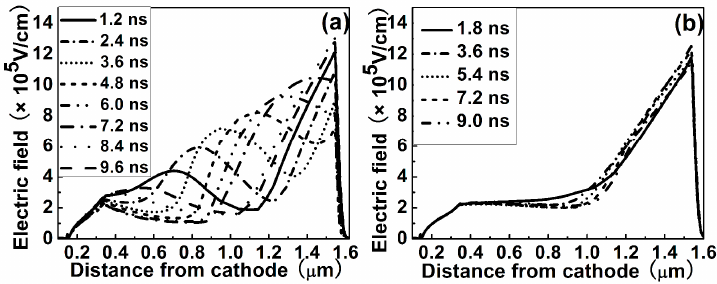
Figure 10. Electric field profiles of the diode derived inside one oscillation circle at the same time steps, when L ac = 1.2 μ m, under ( a ) EB and ( b ) NEB models.